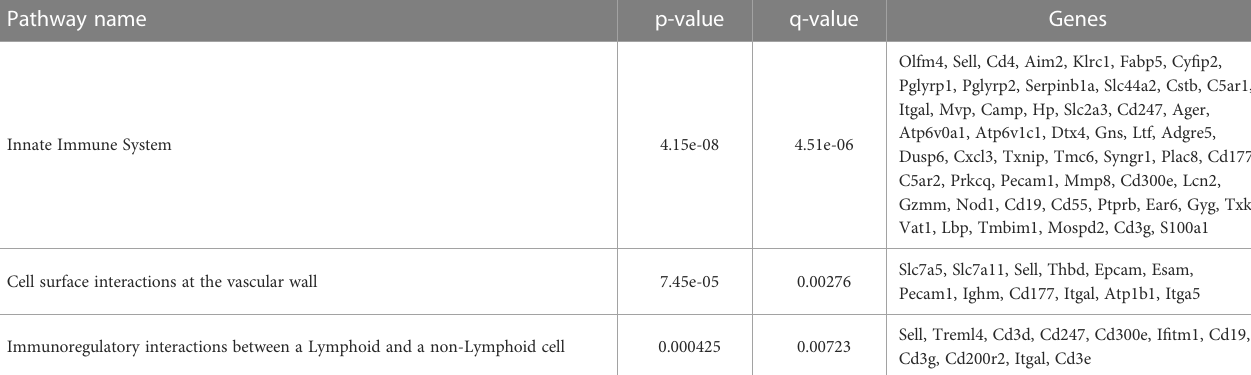
TABLE 4 CD11b-hi DCs selected overrepresented pathways.